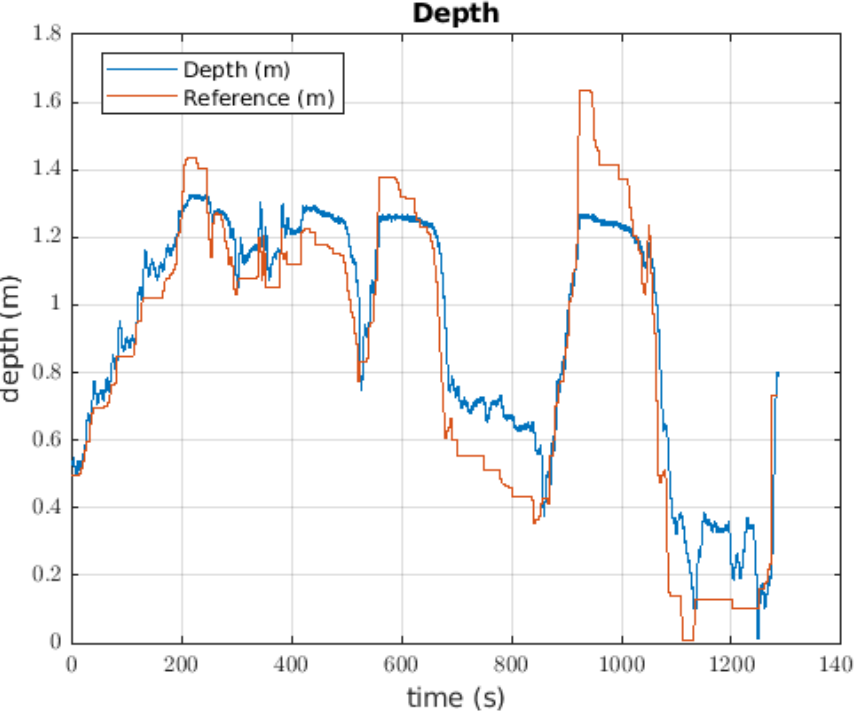
Figure 21. Depth controller used by the robot to catch a plant on the pool